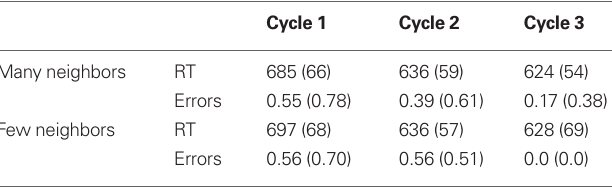
Table 3 | Mean naming latencies and errors across cycles and conditions (in ms; SD in